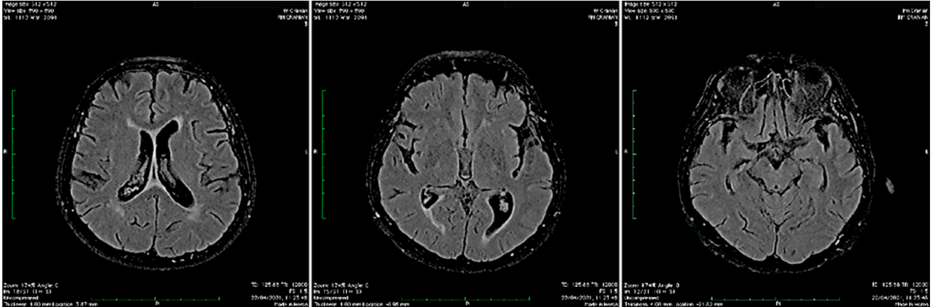
Figure 2. Cerebral MRI, FLAIR sequences revealing mild periventricular microvascular changes and cerebral atrophy.